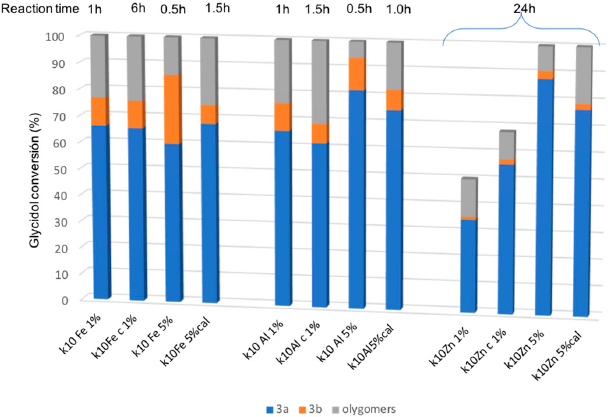
Figure 3. Reaction of glycidol ( 1 ) with methanol ( 2a ) catalyzed by 1% mol and 5% mol K10.